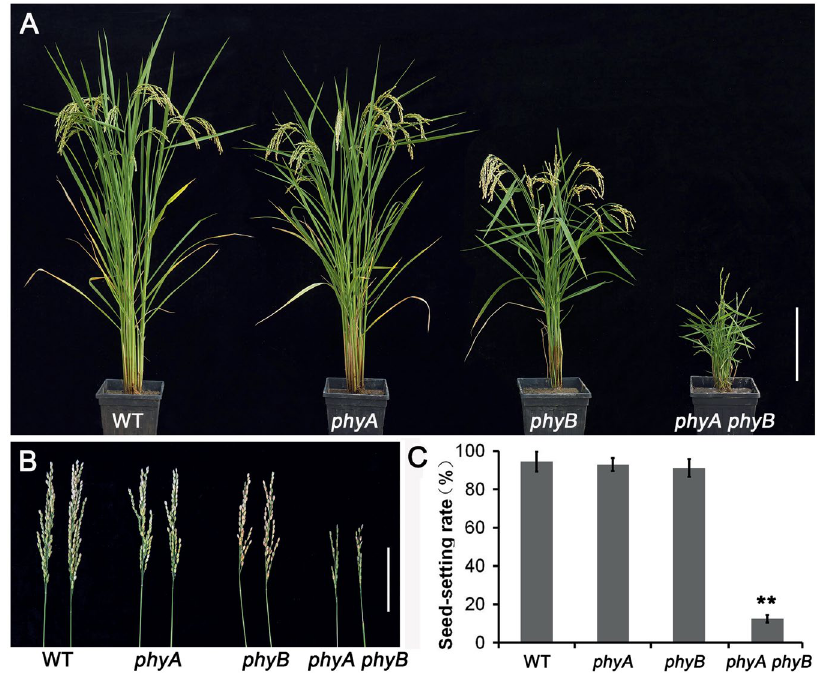
Figure 1. Agricultural traits of the phyA and phyB single mutants, phyA phyB double mutant, and wild-type (WT) rice. ( A ) Comparison of the phyA and phyB single and double mutants with the WT rice at the grain- filling stage. ( B ) The panicles of phyA and phyB single and double mutants, and WT rice. ( C ) Statistical analysis of the seed-setting rates of phyA and phyB single and double mutants, and WT rice. Data were analyzed using paired t tests, and ** means p value < 0.01. Bars = 20 cm in A, 10 cm in